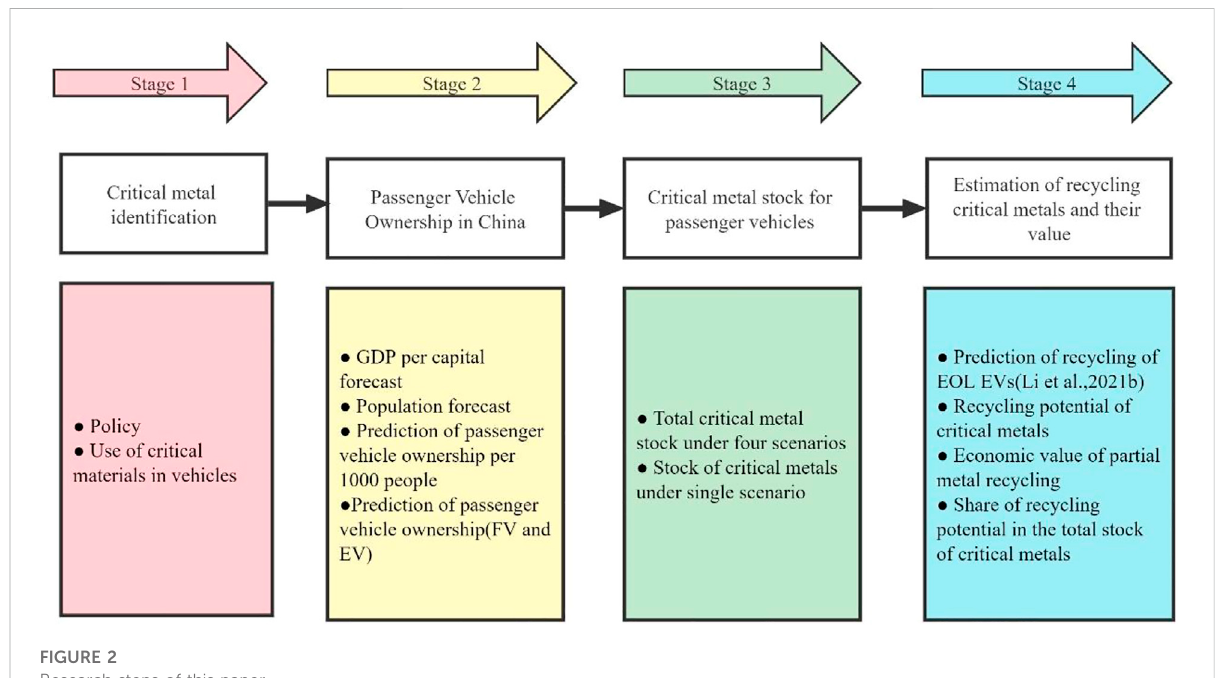
FIGURE 2 Research steps of this